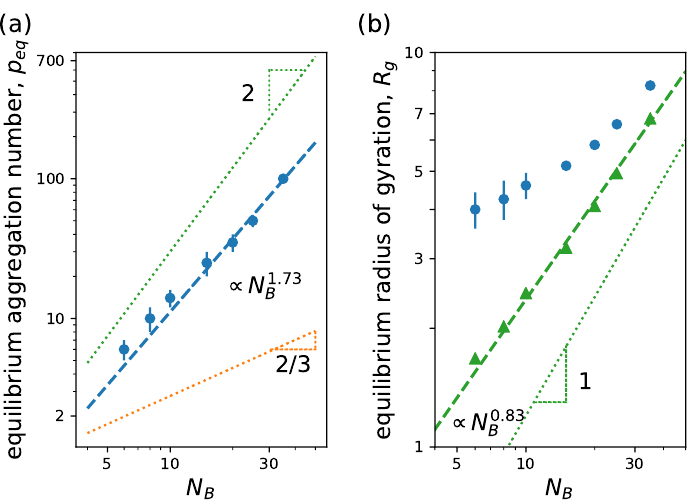
Figure 10. ( a ) Equilibrium aggregation number and ( b ) equilibrium radius of gyration versus degree of polymerization of the hydrophobic block N B . We consider linear–dendritic charged block copolymers with N A = 14 ( g = 2, q = 2, N s = 2). In ( b ), circle corresponds to the radius of gyration of the whole micelle and triangles to the radius of gyration of the core. Dashed lines correspond to least-squared-method fittings, while dotted lines correspond to scaling predictions from SCF theory for linear block copolymers with ionic hydrophilic block: ( a ) equilibrium aggregation number p eq ∝ N 2/3 σ , and p eq ∝ N 2 for small aggregation number, with p (cid:28) α − 1/2 λ − 1 for large aggregation B B B σ ; ( b ) core R ∝ N B and corona independent of N B [42]. Other system number, with p (cid:29) α − 1/2 λ − 1 B parameters: w c = 2.5, (cid:101) attr = 1.0 and k B T =